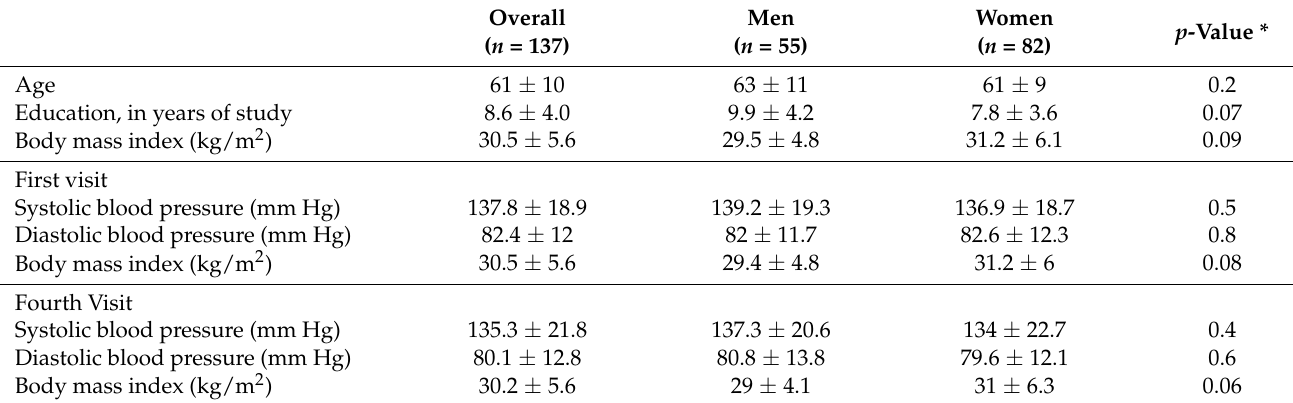
Table 1. Characteristics of the participants. Means ± standard deviation.